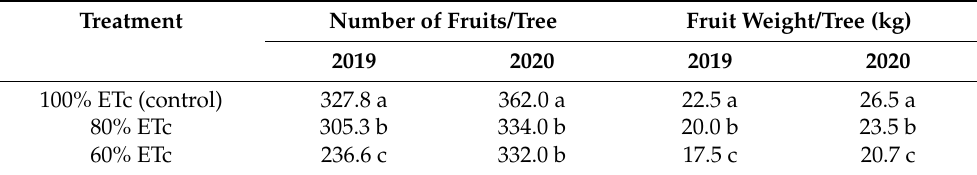
Table 4. Effect of deficit irrigation (as a percentage of crop evapotranspiration, ETc) on the total yield of ‘African Rose’ plum trees during the 2019 and 2020 seasons ( n =